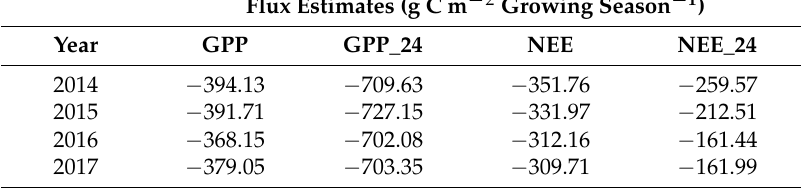
Table 6. Yearly estimates of GPP and NEE per growing season per year. The mention “_24” represents whole day estimates over the growing season while no mention means midday (11 a.m. to 4 p.m.)